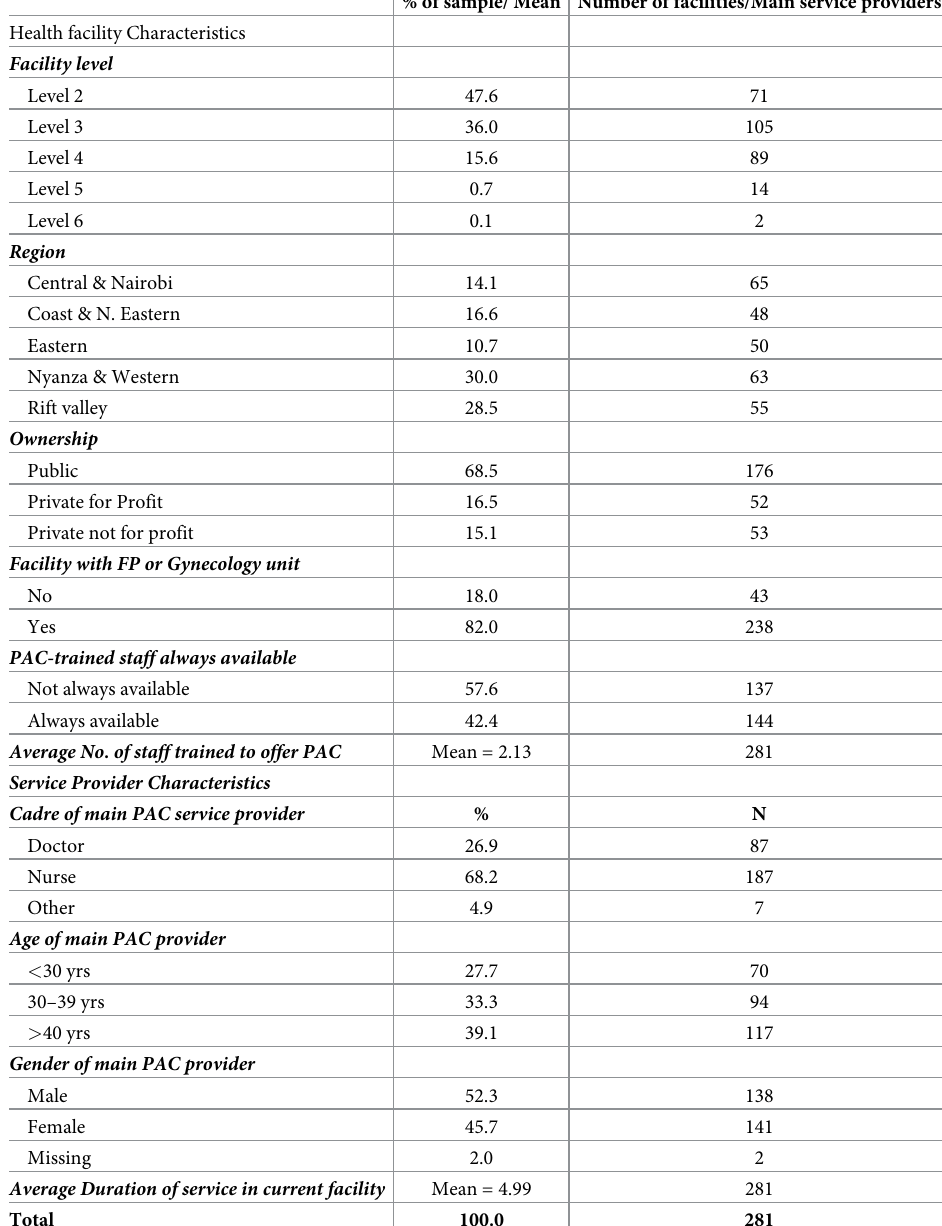
Table 1. Description of healthcare facilities according to facility and service provider characteristics, 2012. % of sample/ Mean Number of facilities/Main service